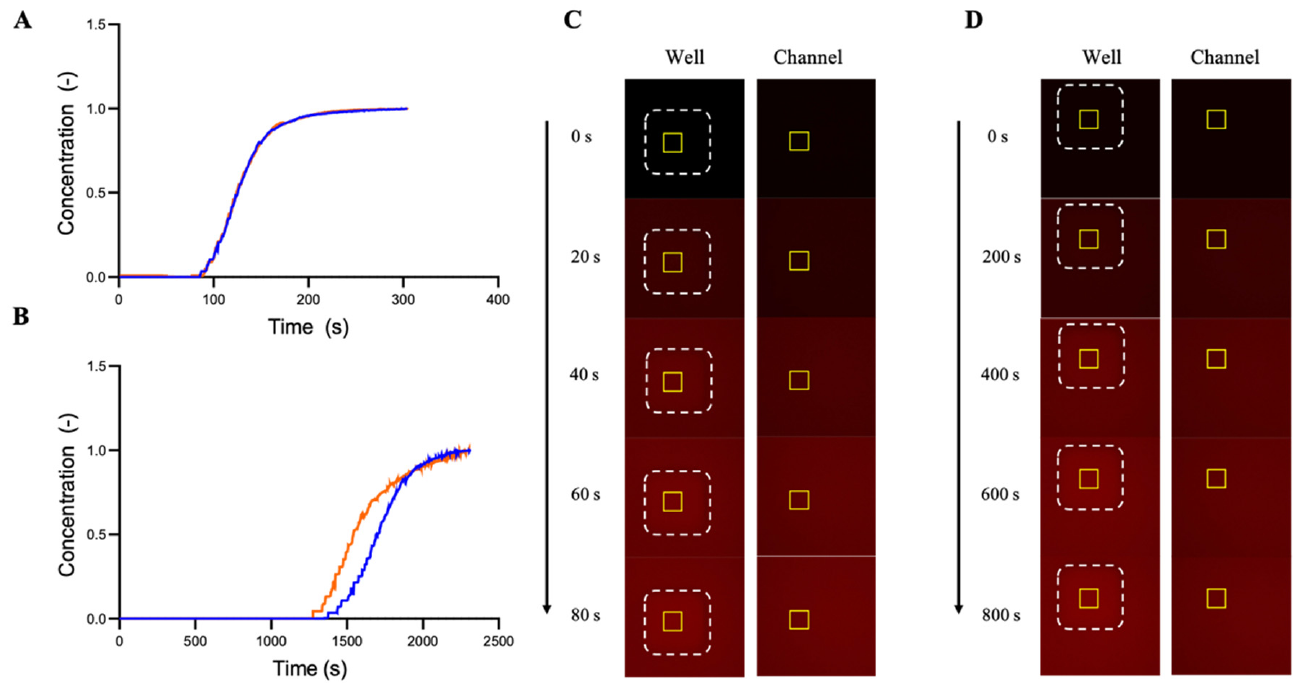
Figure 6. ( A ) Evolution of experimentally determined PI concentration in the well (blue) and middle of the channel (orange) at a flow rate of 120 µ L/min ( B ) Evolution of the experimentally determined PI concentration in the well (blue) and middle of the channel (orange) at a flow rate of 10 µ L/min. ( C ) Mixing of PI in the chip at a flow rate of 120 µ L/min: fluorescent images at different time points; yellow squares represent the analysed area and white dashed squares indicate the edges of the well. ( D ) Mixing of PI in the chip at a flow rate of 10 µ L/min: fluorescent images at different time points; yellow squares represent the analysed area. The time point of 0 s in C and D corresponds to the timepoint at which the intensity curves started to increase in A and B.